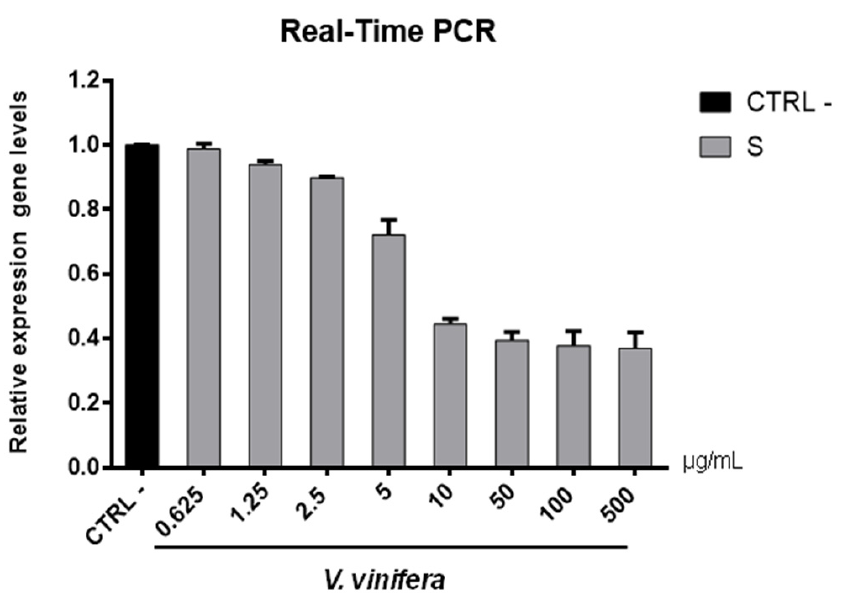
Figure 8. S gene expression analysis in Vero cells. V.vinifera leaf extract at 0.625, 1.25, 2.5, 5, 10, 50, 100, and 500 µ g/mL was incubated with SARS-CoV-2 for 1 h and then the mixture was added on Vero cells for another 1 h. After 2 days post-infection, RNA was extracted, and Real-Time PCR was performed. Relative expression gene levels were calculated with respect to CTRL − .